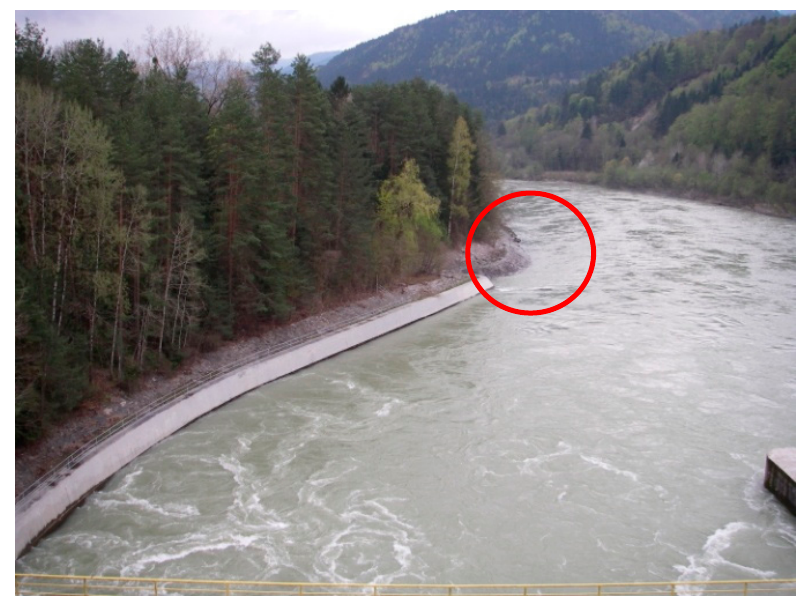
Figure 5. Project area, planned entrance into fish pass, Schwabeck Hydro Power Plant, Drava, Carinthia/Austria.